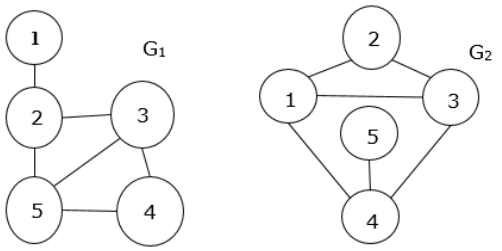
Figure 5. Graphs in example 6.